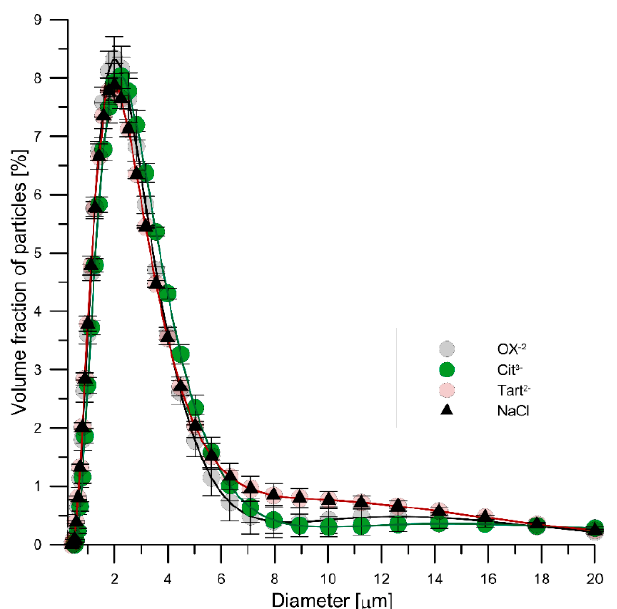
Figure 8. Comparison of the volume particle size distribution of the hydroxyapatite samples conditioned for 14 days in the solution of 0.001 mol / dm 3 NaCl (black triangle), HAp in the solution with the 0.001 mol / dm 3 NaCl + 0.001 mol / dm 3 oxalate ions (grey circle), HAp in the solution with the 0.001 mol / dm 3 NaCl + 0.0001 citrate ions (geen circle) and HAp in the solution containing 0.001 mol / dm 3 NaCl + 0.001 mol / dm 3 tartrate ions.